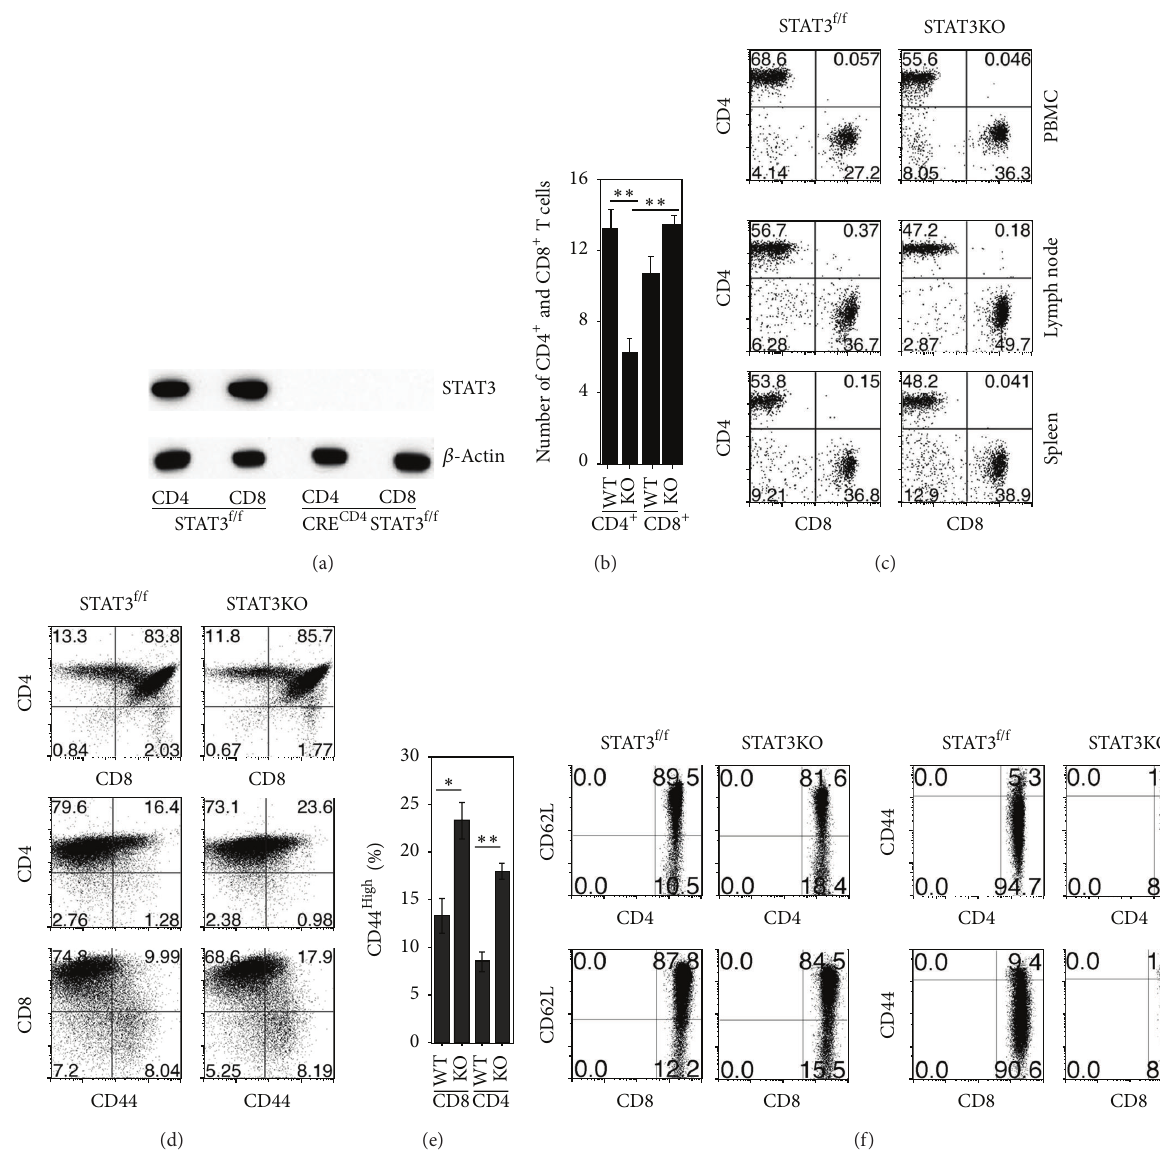
Figure 1: STAT3-deficient CD8 + T cells exhibit a preactivated phenotype. (a) Purified CD4 + or CD8 + T cells derived from the spleen and LN of control (STAT3 f/f ) and CD4-STAT3KO mice (CRE CD4 STAT3 f/f ) were analyzed by western blotting. (b) Eight-week-old WT or STAT3KO mice were euthanized, and lymph nodes (LN) and spleen were harvested. Total CD4 + and CD8 + lymphocytes isolated from LN and spleen were quantified on a Vi-CELL Cell Viability Analyzer (Beckman Coulter). (c) Freshly isolated T cells from the PBMC, LN, or spleen were stained with Abs to CD3, CD4, or CD8 and analyzed by FACS. (d, e, f) Relative amounts of activated T cells in unstimulated thymocytes (d, e) or spleen (f) of the WT or STAT3KO mice were determined by FACS analysis of CD44 + or CD62L + T cells. Plots (d, e, f) were gated on CD3, and numbers in quadrants represent percentage of T cells expressing CD4, CD8, or CD44. Data represent at least 3 independent